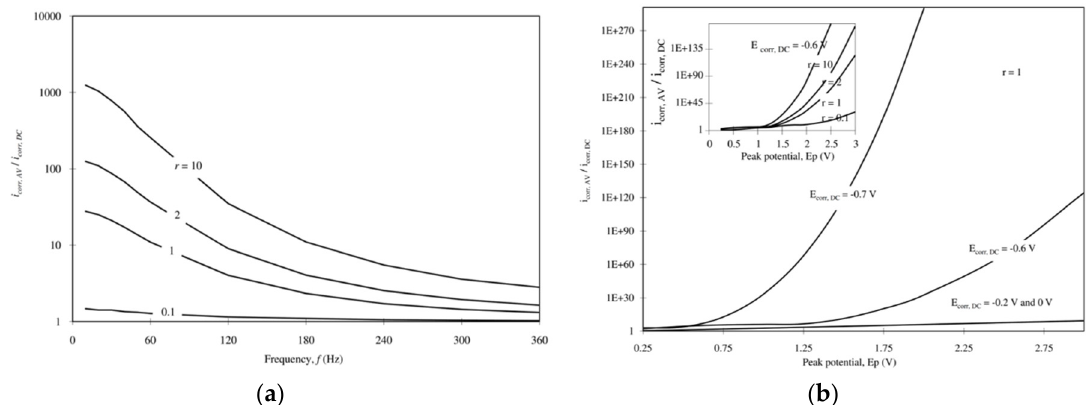
Figure 15. A nonlinear model for corrosion of metals subjected to AC corrosion [43]: ( a ) dimensionless corrosion current vs. frequency, ( b ) dimensionless corrosion current vs. peak potential and DC corrosion potential. Legend: E corr,DC = corrosion potential in the absence of AC (V vs. SCE); E p = AC peak potential (V vs. SCE); r = β a / β c .